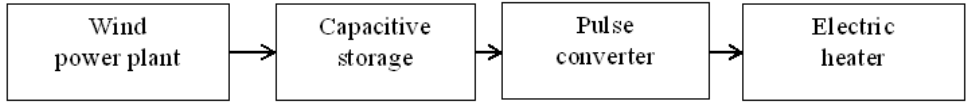
Figure 1. Block diagram of electric pulse heater with capacitive storage [own elaboration]—the structural diagram is based on known principles of operation of the constituent elements.